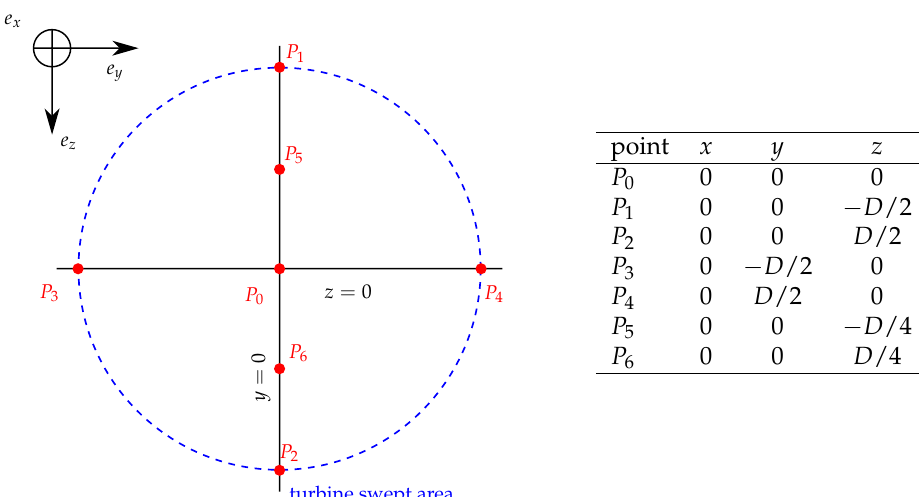
Figure 4. Front view of the ADV measurement points describing the swept area of the turbine and their coordinates expressed in diameter D = 0.724 m. Points 0 to 2 and 5 and 6 are acquired at I FREMER . Points 0 to 2 are acquired at C NR -I NM . Points 0 to 4 are acquired at F LO W AVE